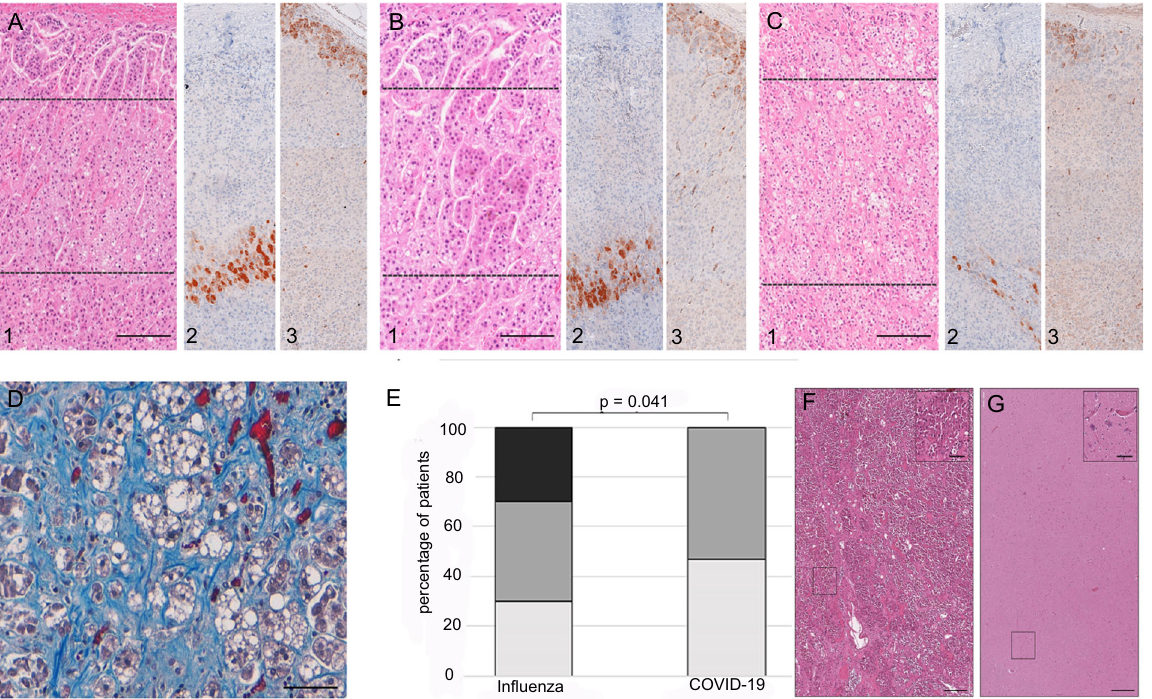
Fig. 5 Disruption of zonation in adrenal glands from COVID-19 patients. Histopathological examination of adrenal glands ( n = 30) reveals disruption of adrenal gland zonation in COVID-19 patients. In panel A normal zonation in zona glomerulosa, zona fasciculata, and zona reticularis is shown with hematoxylin-eosin staining (H&E) (A1) and immunohistochemistry for CYB5A (zona reticularis, A2) and for CYB11B2 (zona reticularis, A3). Panel B displays moderate disruption of the zonation and in panel C zonation of the cortex is not visible in H&E staining and is severely disrupted as visualized by immunohistochemistry. Quanti fi cation of disruption (score 0 (intact zonation, black), score 1 (moderate disruption, gray), and score 2 (severe disruption, white)) and statistical analysis ( E ) showed signi fi cantly more severe disruption of zonation in COVID-19 patients compared to in fl uenza patients ( p values were calculated using Chi-squared test). Source data are provided as a Source Data fi le. Marked interstitial fi brosis with collagen matrix production indicated in blue ( D , Masson´s trichrome stain) was noticed in patients with seroconversion. Scale bars in A – C correspond to 200 µ m in D to 100 µ m. H&E staining of the pituitary gland and hypothalamus ( F , G ) shows no signi fi cant alterations (overview (scale bar = 100 µ m and magni fi ed inlet (scale bar = 10 µ